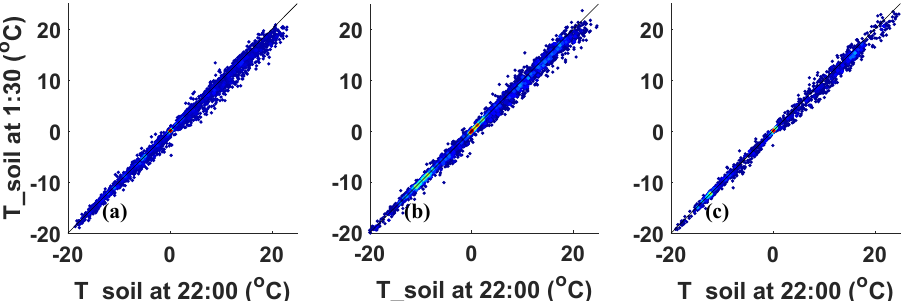
Figure 18. Comparison of 5 cm soil temperature between S1B overpass time (22:00) and AMSR2 overpass time of the descending orbit (1:30) over cultivated ( a ), grassland ( b ), and forest ( c ) in the Genhe watershed.